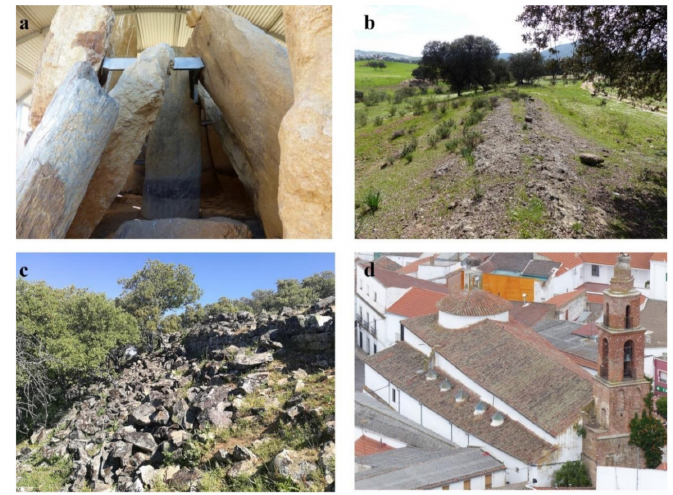
Figure 2. Monuments located in the area surrounding the Cerro del Castillo of Belmez (CCB). Copyright “Ager Mellariensis” / AEI FEDER HAR 77136-R. ( a ) Casas de Don Pedro megalithic monument (5500–2500 BC). ( b ) Roman road in Espiel (1 BC). ( c ) Andalus í fortress in El Hoyo (10 AD). ( d ) Medieval church of Belmez (13